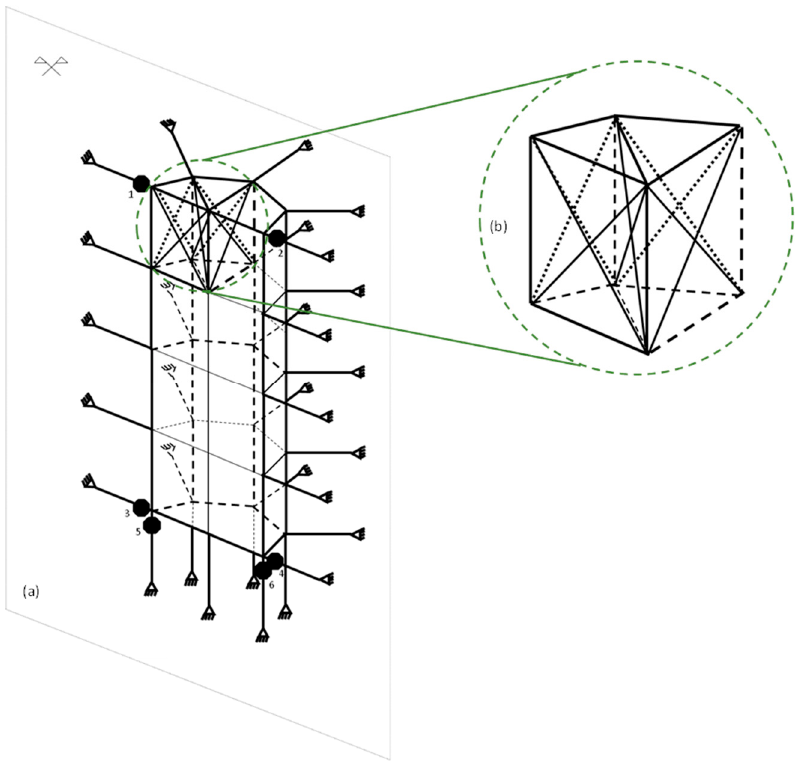
Figure 13. ( a ) Concrete footing design with the height comprised of four horizontal divisions. ( b ) Close-up view of a subdivision.